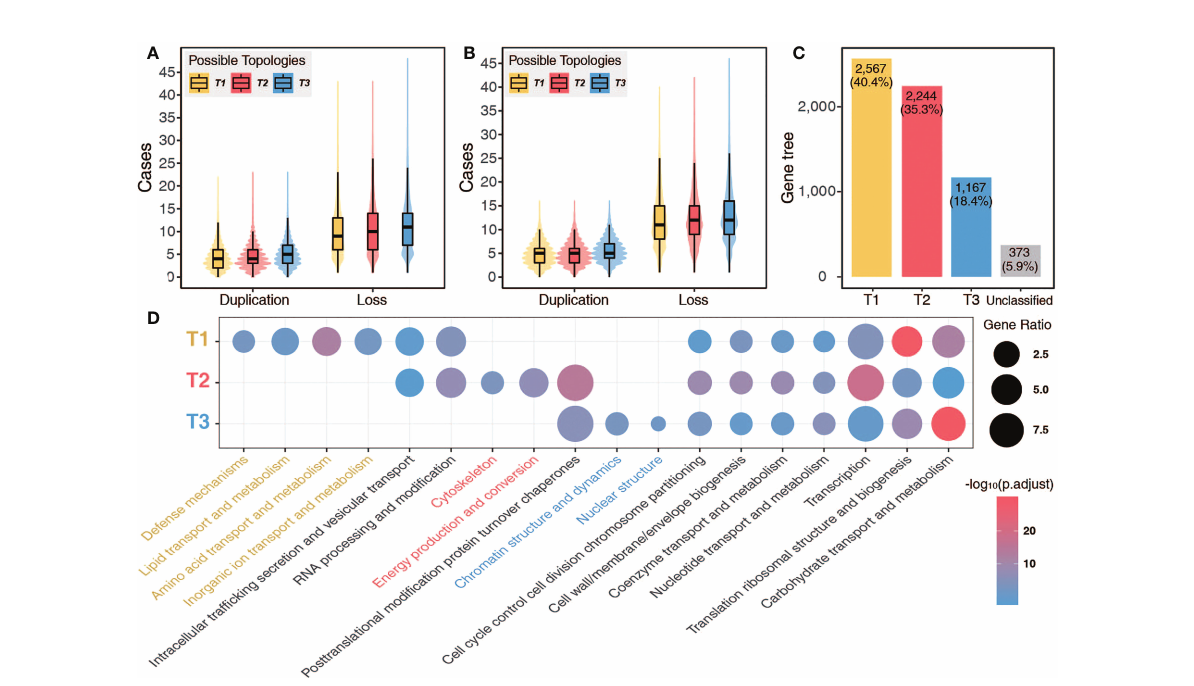
FIGURE 4 Gene loss after allopolyploidization. (A, B) Cases of gene duplication and loss in each gene tree by matching preliminarily fi ltered (A) and deep fi ltered (B) gene trees with three possible topologies, respectively. (C) Number of gene trees supporting the three possible MUL tree topologies. (D) Clusters of Orthologous Groups (COG) functional enrichment of orthogroups following the different gene retention/loss scenarios (T1, T2, and